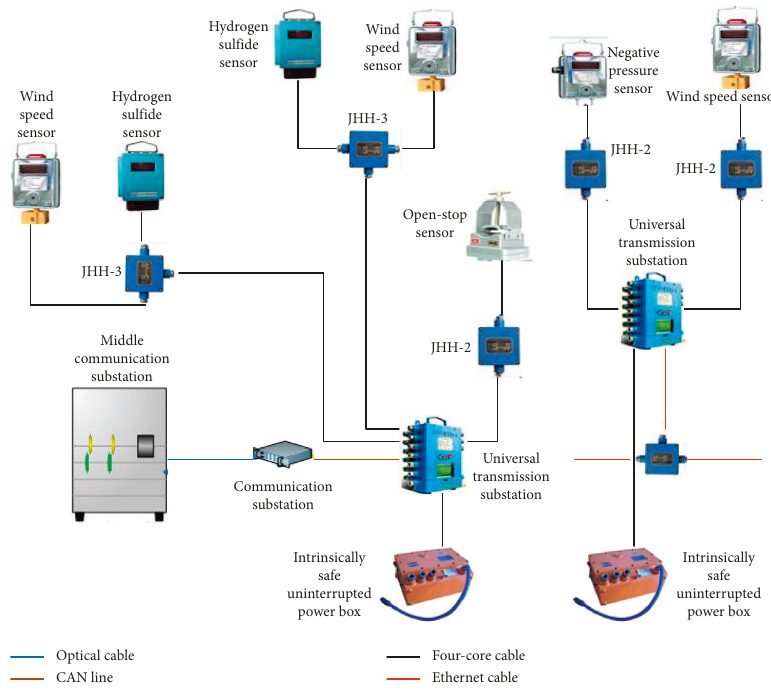
Figure 1: Schematic diagram of ventilation system monitoring